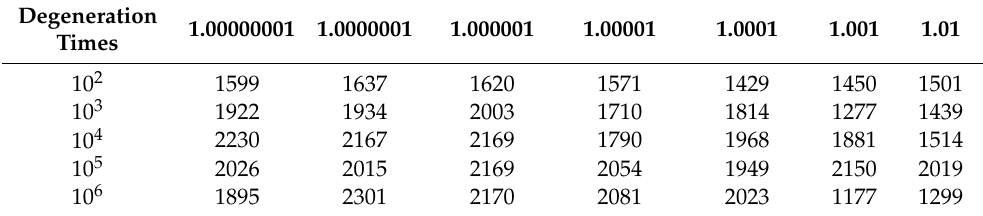
Table 8. Effect of degeneration times on low-probability password hits (Rule 5).